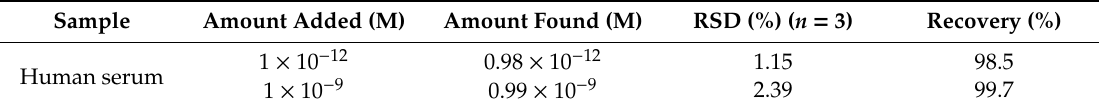
Table 2. α -Syn oligomer detection in human serum for the real sample application of Apt / ERGO-GCE. Table 2. α-Syn oligomer detection in human serum for the real sample application of Apt/ERGO- Sample GCE.